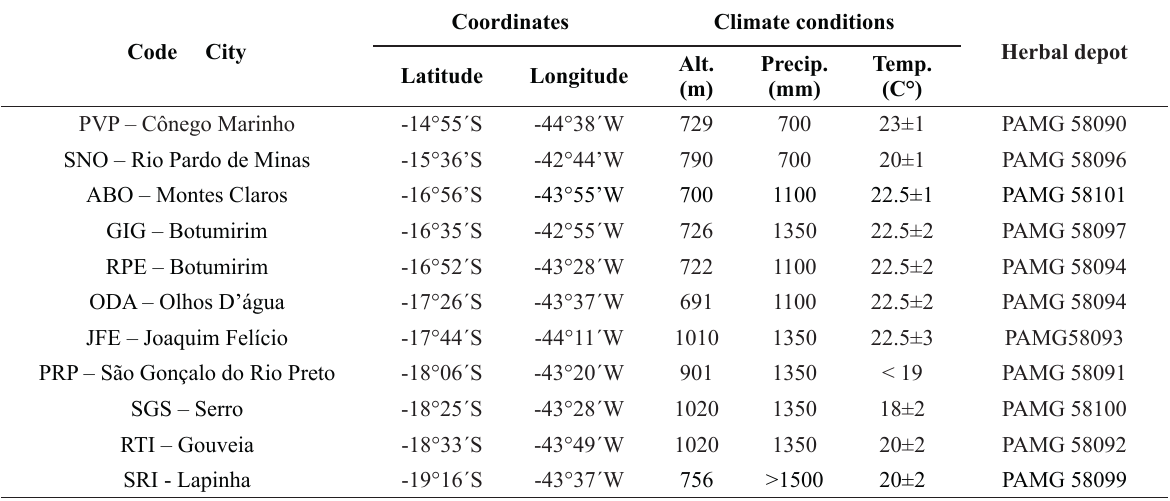
Location of eleven naturally occurring populations of Lippia rotundifolia in Minas Gerais,